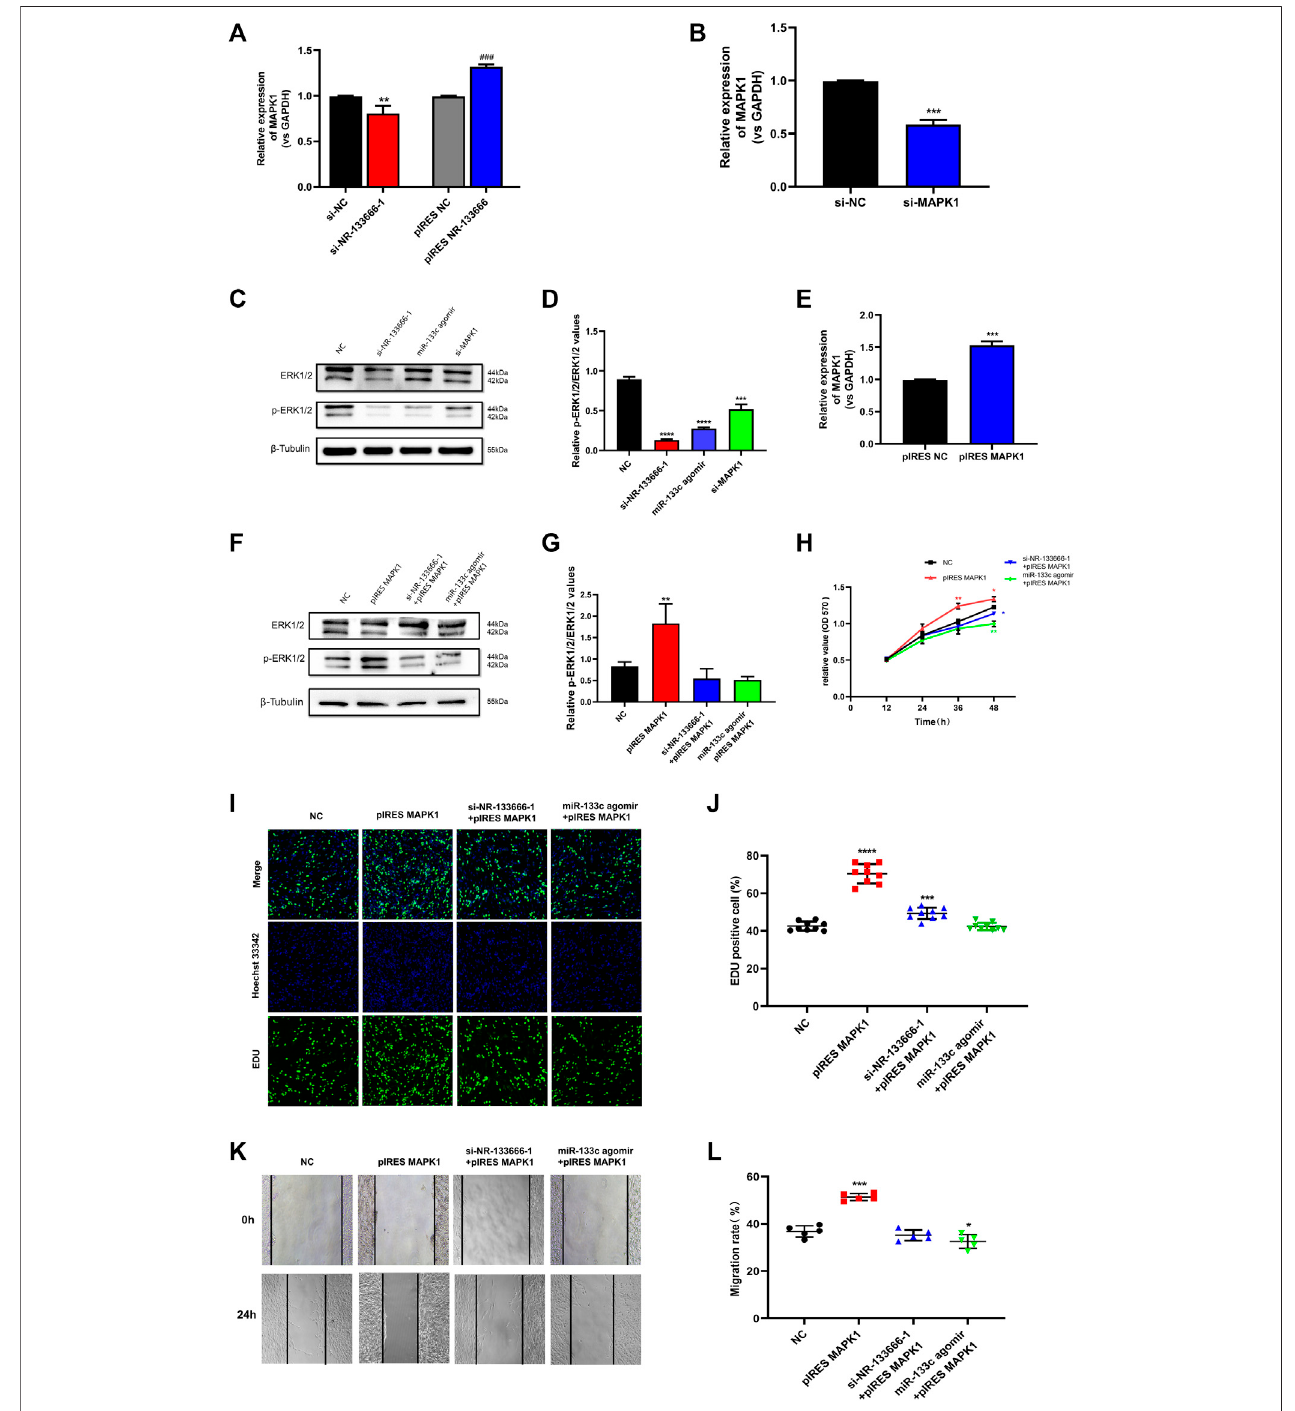
FIGURE 7 | lncRNA NR-133666 promoted CIA FLS proliferation and migration through miR-133c/MAPK1 axis. (A) MAPK1 expression in si-NR-133666 – 1 and pIRES NR-133666 groups. (B) qRT-PCR detected the transfection effect of si-MAPK1. (C,D) The Western blot analysis showed that knockdown NR-133666 and MAPK1 or overexpression miR-133c can reduce the expression of p-ERK1/2 in CIA FLS. (E) qRT-PCR showed the transfection effect of pIRES MAPK1. (F,G) The protein expression of p-ERK1/2 was detected by Western blot after transfecting pIRES MPAK1, si-NR-133666-1+pIRES MAPK1 and miR-133c agomir + pIRES MAPK1 in CIA FLS. (H – L) Functional rescue experiments were performed on proliferation and validated migration in pIRES MPAK1, si-NR-133666-1+pIRES MAPK1 and miR-133c agomir + pIRES MAPK1 (100×). Compared with controls, * p < 0.05, ** p < 0.01, *** p < 0.001, **** p < 0.0001; compared with pIRES NC, ### p < 0.001.